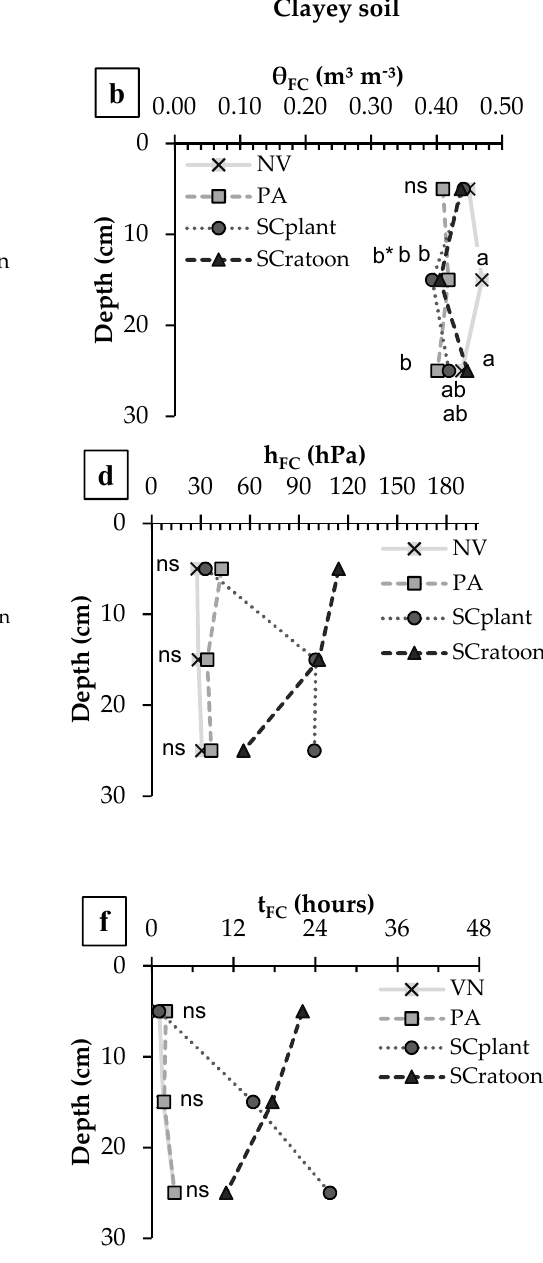
Figure 3. Water content at field capacity (θ FC ) ( a , b ), water tension at field capacity (h FC ) ( c , d ), drainage time to reach the field capacity (t FC ) ( e , f ) from 0–10, 10–20, and 20–30 cm layers under native vegetation (NV), pasture (PA), sugarcane plant (SCplant), and sugarcane ratoon (SCratoon) at Sandy and Clayey soil. * Mean values within each site in the same depth followed by the same letter do not differ among themselves according to Tukey’s test ( p < 0.05). ns Not significant.